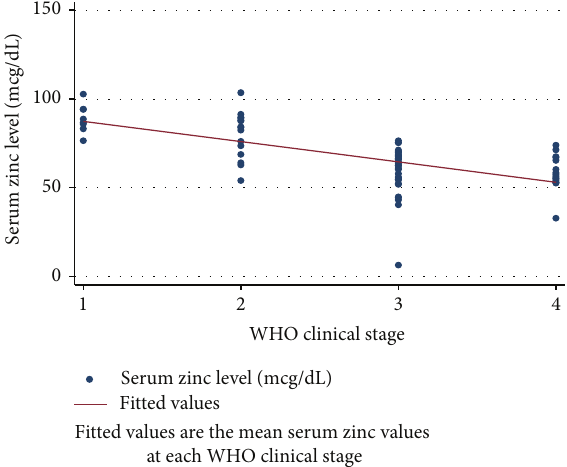
Figure 1: The relationship between Serum zinc levels and clinical stage of HIV infected subjects.